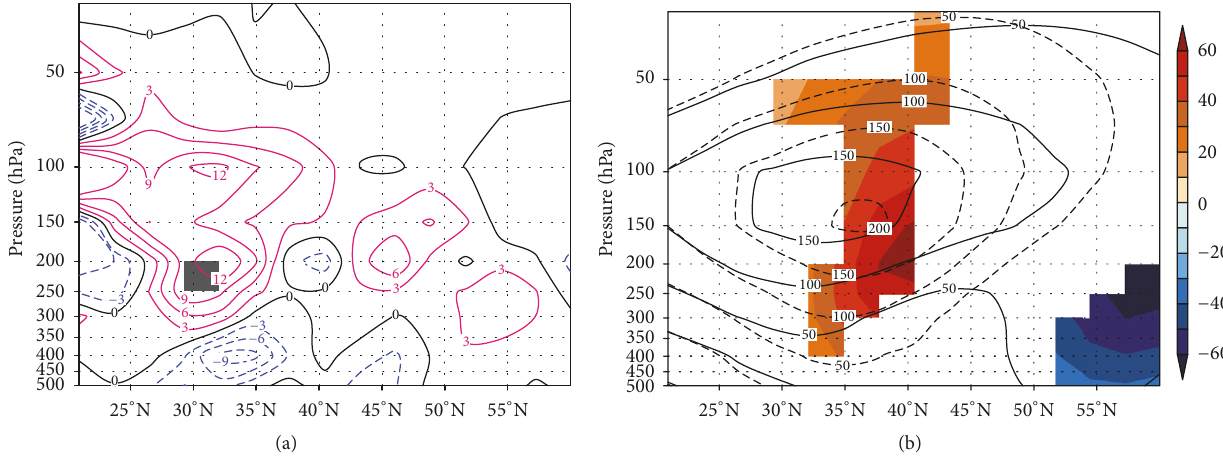
Figure 3: (a) is the same as Figure 2, but for horizontal divergence (units: 10 −7 /s) and shaded values that are exceeding 80% confidence level; (b) is the same as Figure 1(g), but for vertical-latitude cross section along 56 ∘ E and shaded values that are exceeding 95% confidence level.